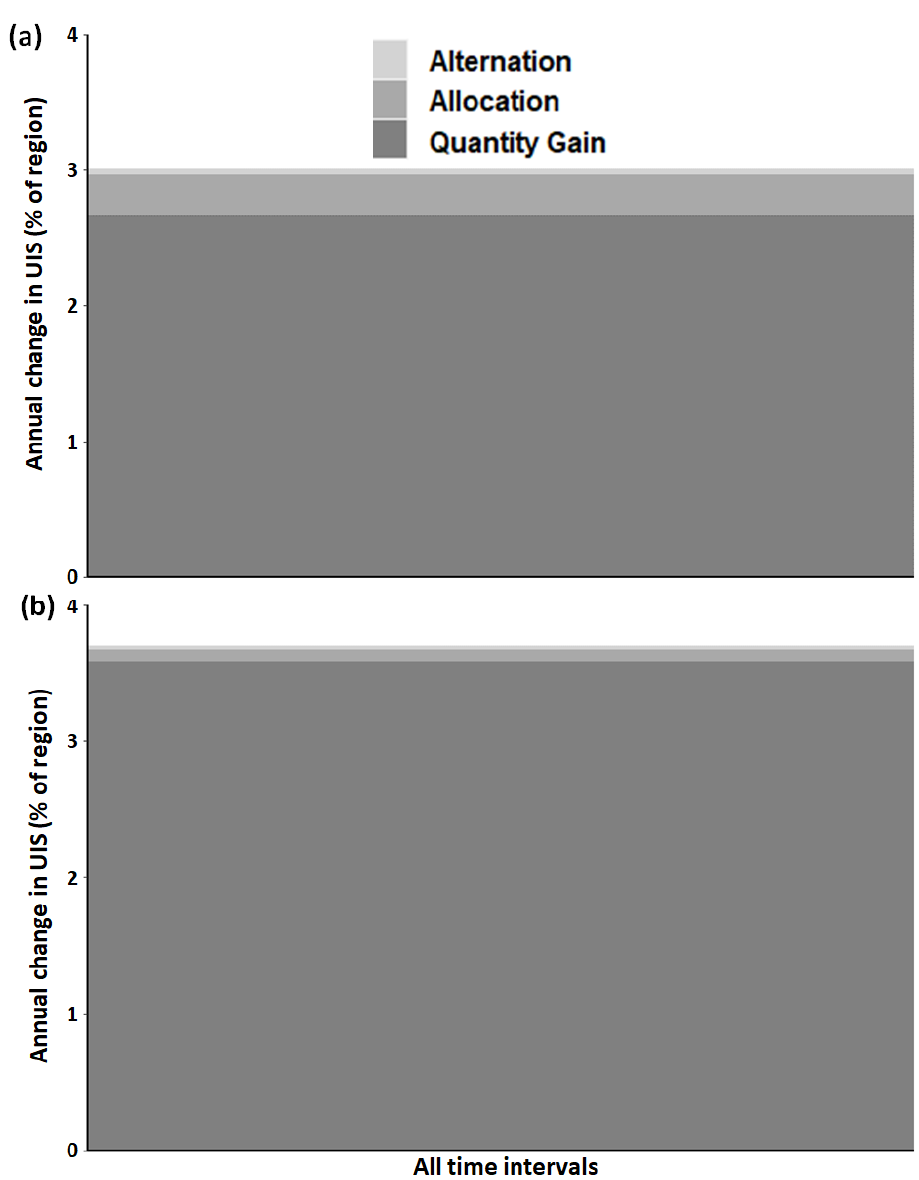
Figure 7. Stacked bars of the components of change of UIS change in ( a ) Accra and ( b ) Kumasi during two time intervals: 2000 − 2011 and 2011 − 2021. The % of the region is the unified region.